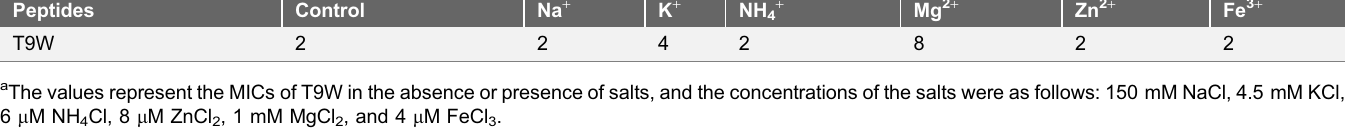
Table 4. MIC values of T9W against P. aeruginosa 27853 in the presence of physiological salts a . Peptides Control